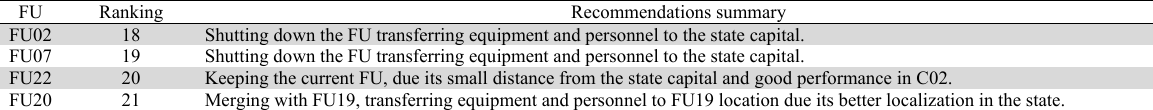
Recommendations summary for least viable